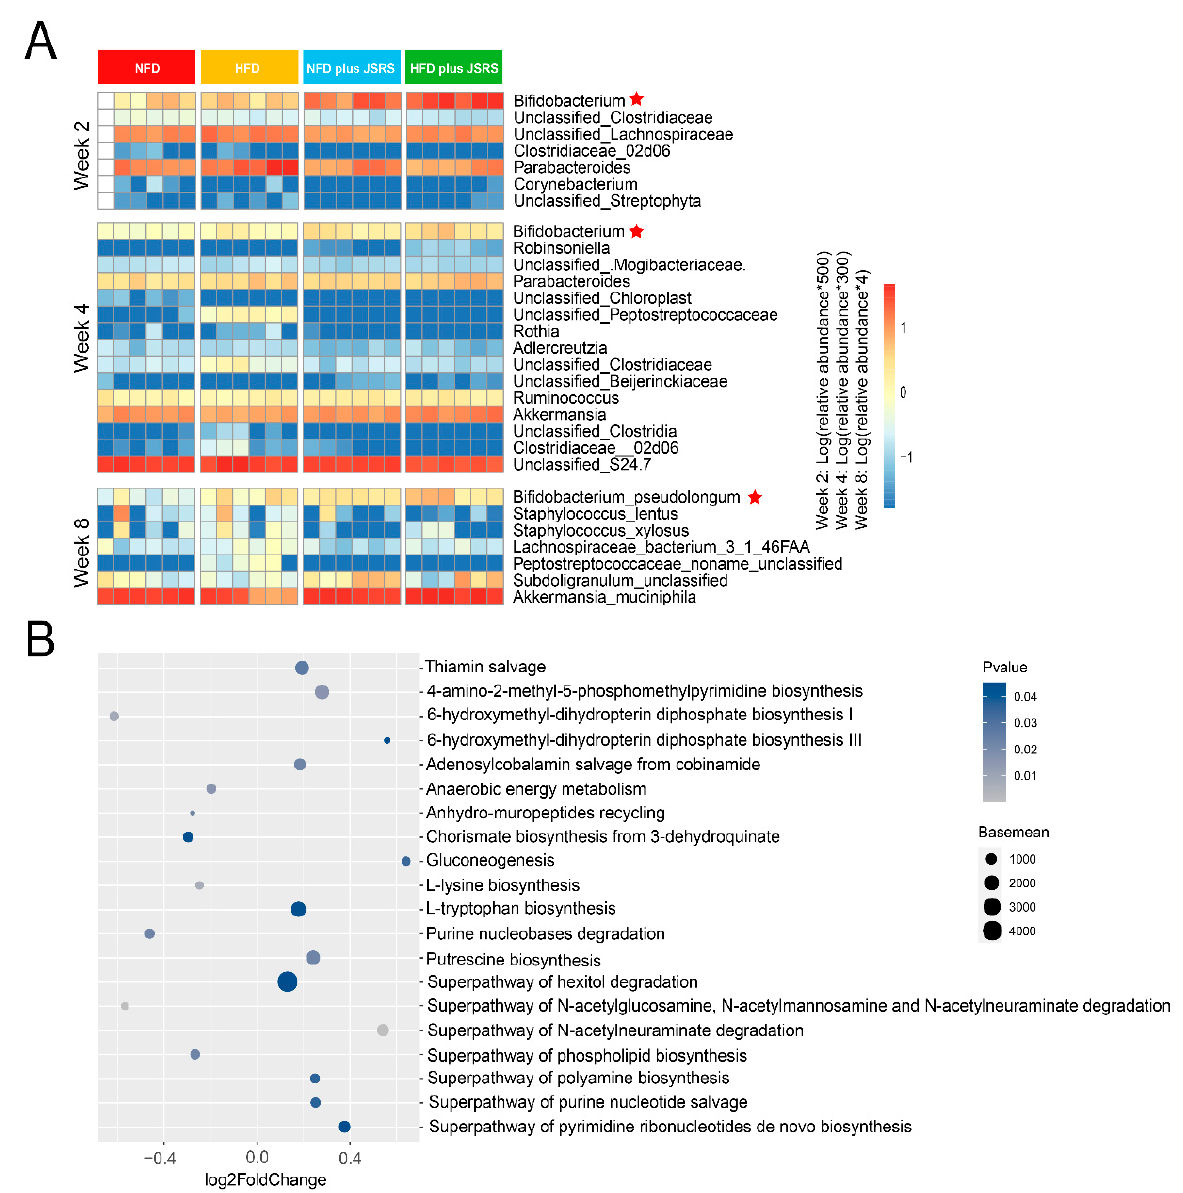
Figure 3. Comparison of differential microbial and metabolic pathways. ( A ) Variations of differential bacteria in different groups at weeks 2, 4, and 8 in Stage I. The significant difference genera (week 2 and week 4) and species (week 8) were screened (Wilcoxon rank-sum test). The depth degree of color represents the relative abundance of the genus or species (blue indicates a small number, and red indicates a large number). ( B ) Metabolic pathway analysis was performed based on the shotgun metagenomic sequencing data in Stage I. Significantly different pathways with baseline ranking in the top 20 were screened out. Log 2 foldchange value greater than 0 indicated that the enrichment abundance in the JSRS group (the combination of the HFD plus JSRS group and the NFD plus JSRS group) is greater than that in the N and H group (the combination of the NFD group and the HFD group). (JSRS, Jackfruit seed sourced resistant